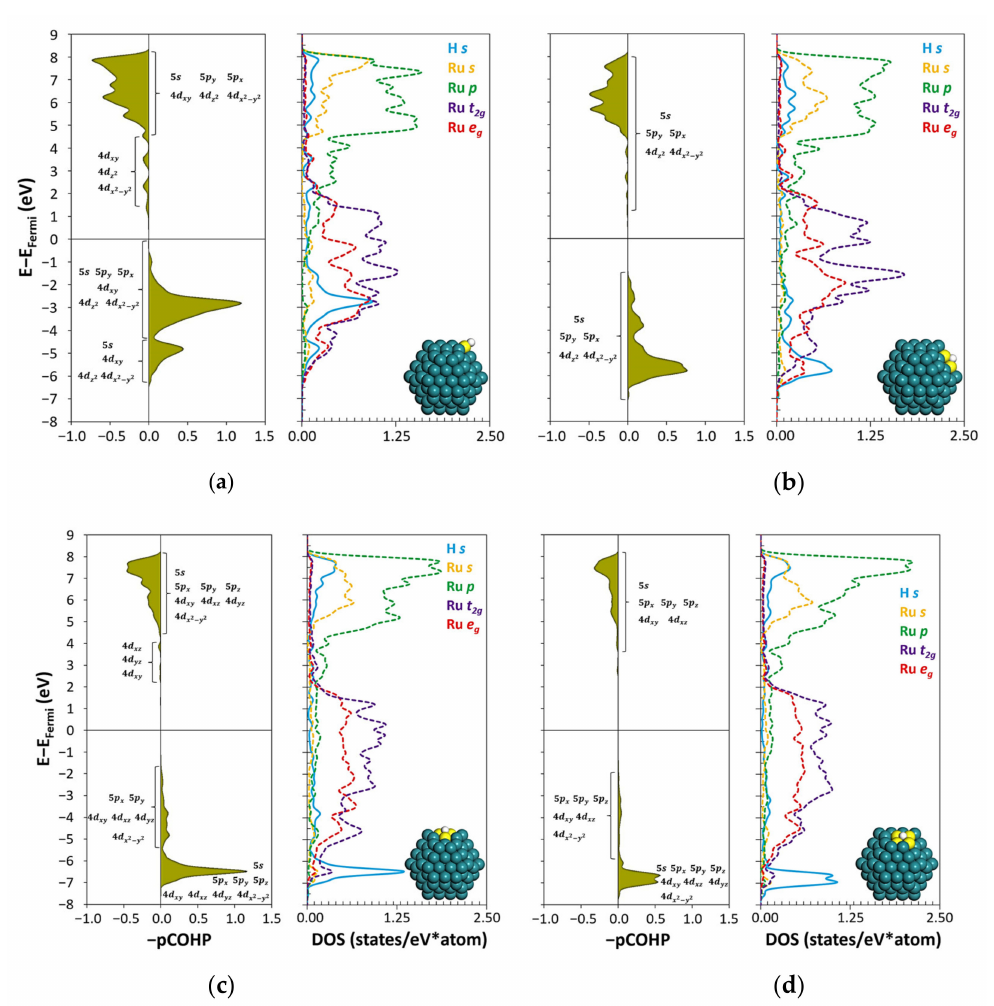
Figure 3. Bonding analyses of the H atom interacting on ( a ) top, ( b ) bridge, ( c ) 3F, and ( d ) 4F sites of Ru 153 . The projected crystal orbital Hamilton population and the density of states of the H atom (white sphere) interacting with the Ru atoms (yellow spheres) are